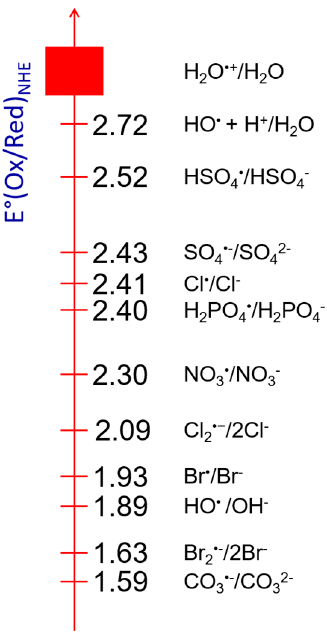
Figure 3. Scale of the values of the redox potential of certain transient radicals with respect to the standard hydrogen electrode (V/NHE).